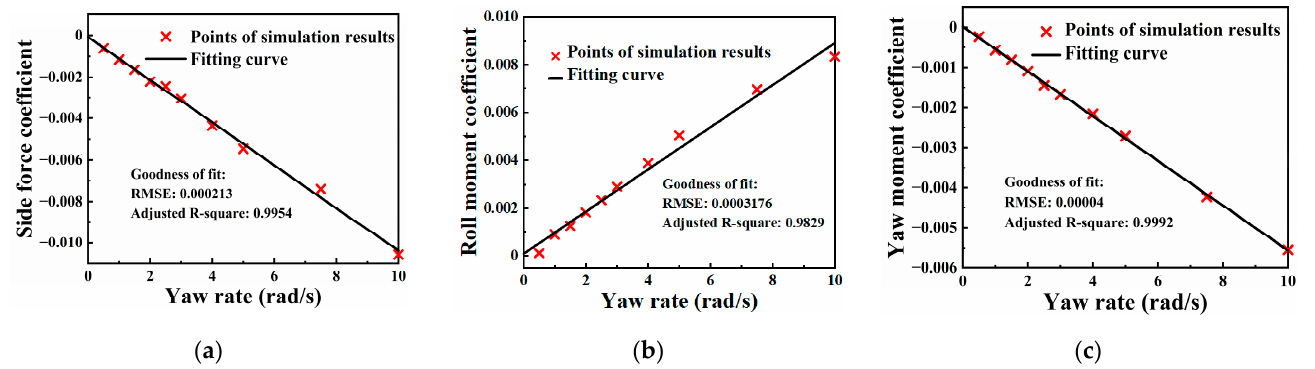
Figure 9. Curve fitting of aerodynamic coefficients versus the yaw rate: ( a ) side force; ( b ) roll moment; ( c ) Yaw moment.